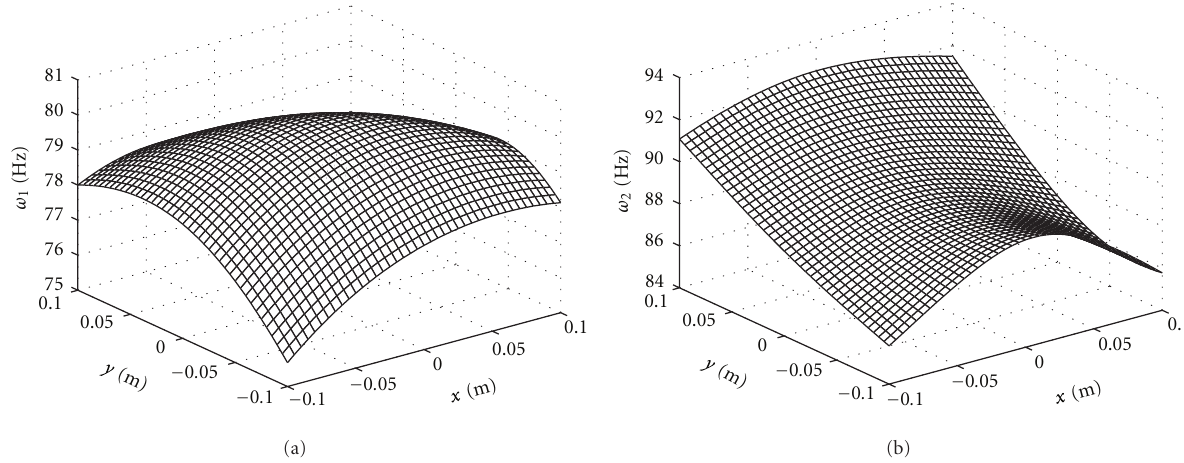
Figure 5: Distributions of the natural frequencies in the workspace. (a) First-order natural frequency. (b) Second-order natural frequency.